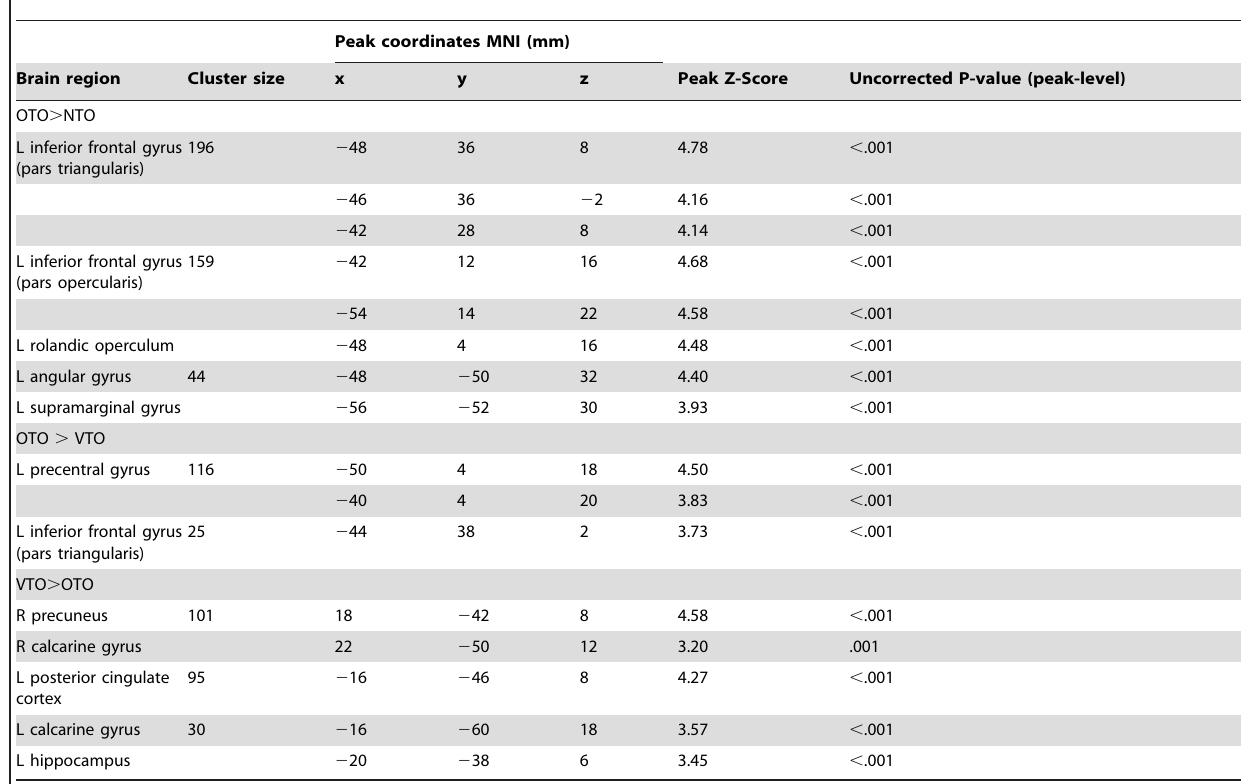
Table 1. Brain regions showing activation differences between object sets after training and an interaction between the factors TIME and OBJECT SET.